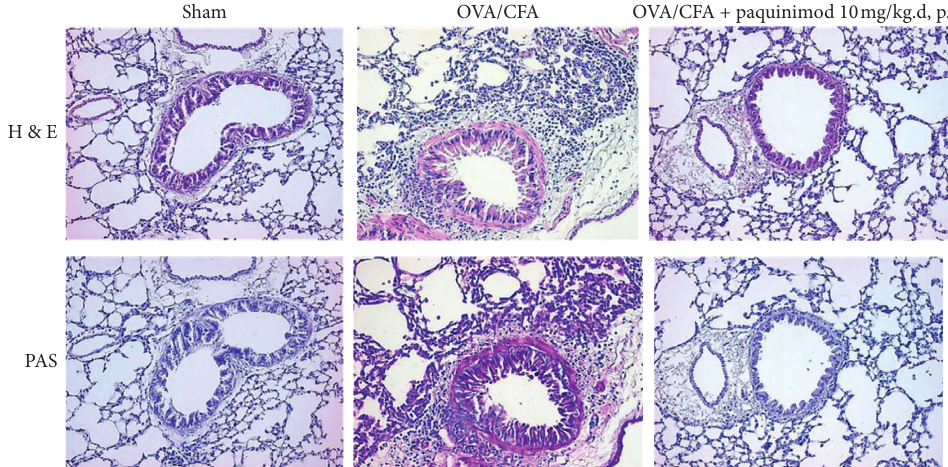
Figure 2: A representation picture of hematoxylin and eosin (H&E) and periodic acid-Schiff (PAS) staining of lung tissue. Lung sections were obtained from the sham- and OVA/CFA-treated mice with or without paquinimod treatment of 10mg/kg/day, p.o. Tissue sections were stained with PAS to determine the presence of goblet cells (microscopy image (x200)).